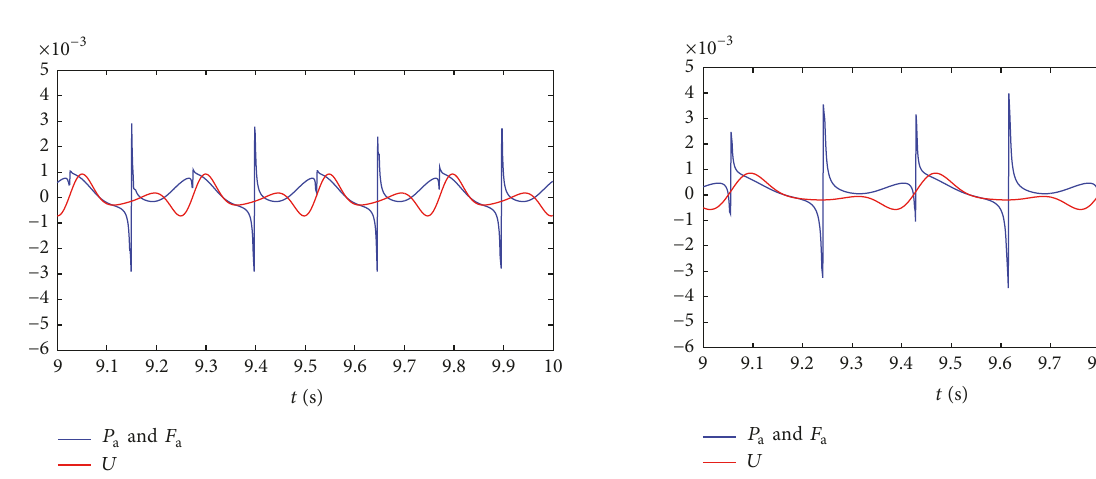
Figure 4: SDRE control signal for constant velocity ( 𝑥 2∗ = 25.245 rad/s = 30 km/h) with double-cylinder excited by pressure (normalized).